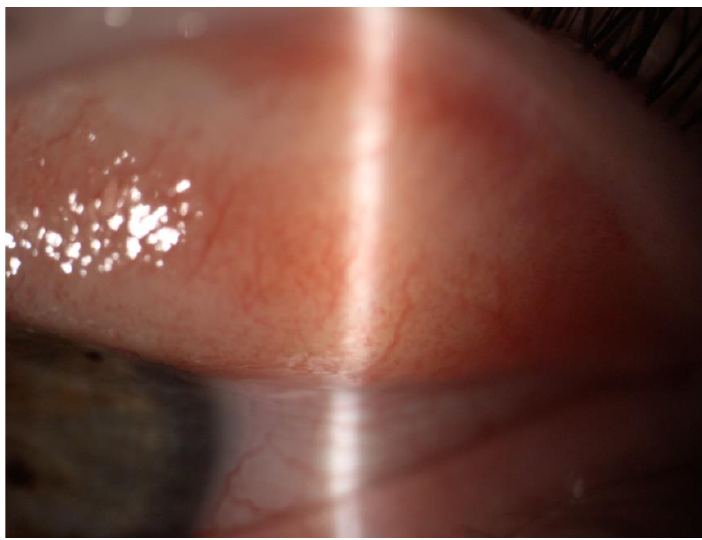
Figure 1. Follicle formation on the conjunctiva of the eyelid accompanying COVID-19 infection.